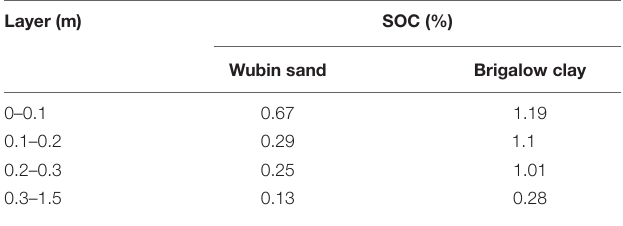
TABLE 2 | Initial SOC in Wubin sand and Brigalow clay (soil data collected by